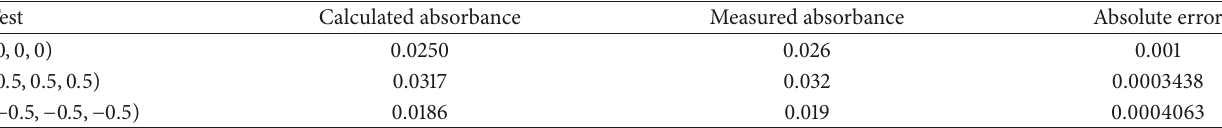
Table 5: Comparison between the measured absorbance and the calculated absorbance.